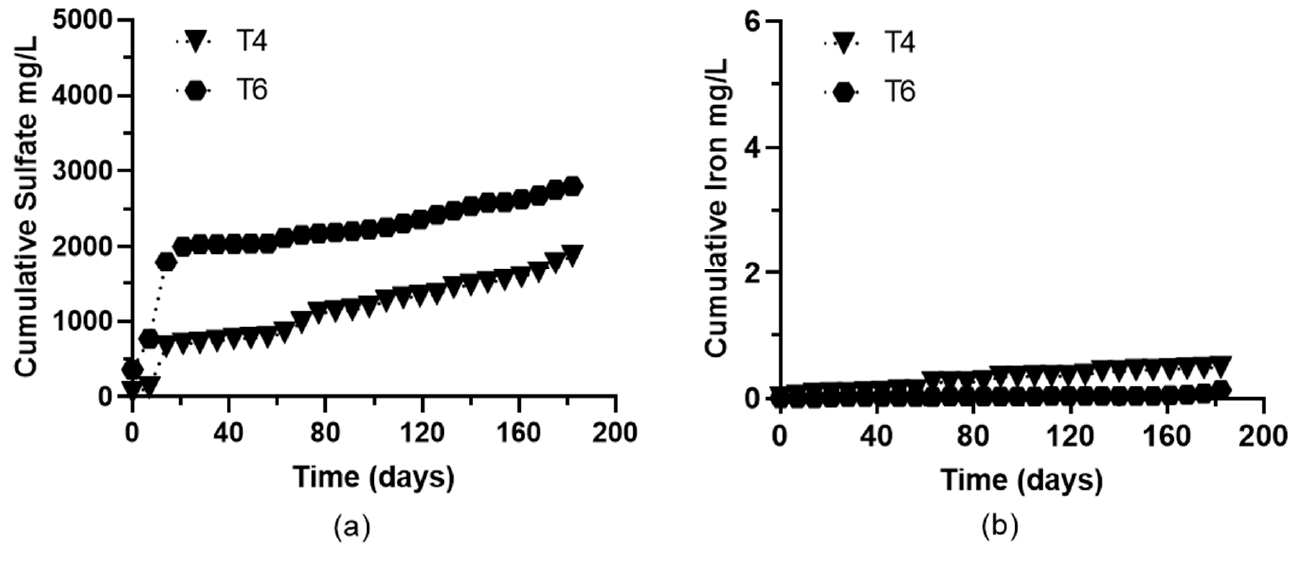
Figure 6. Evolution of cumulative concentrations of sulfate ( a ) and iron ( b ) collected throughout the humidity cells [36].